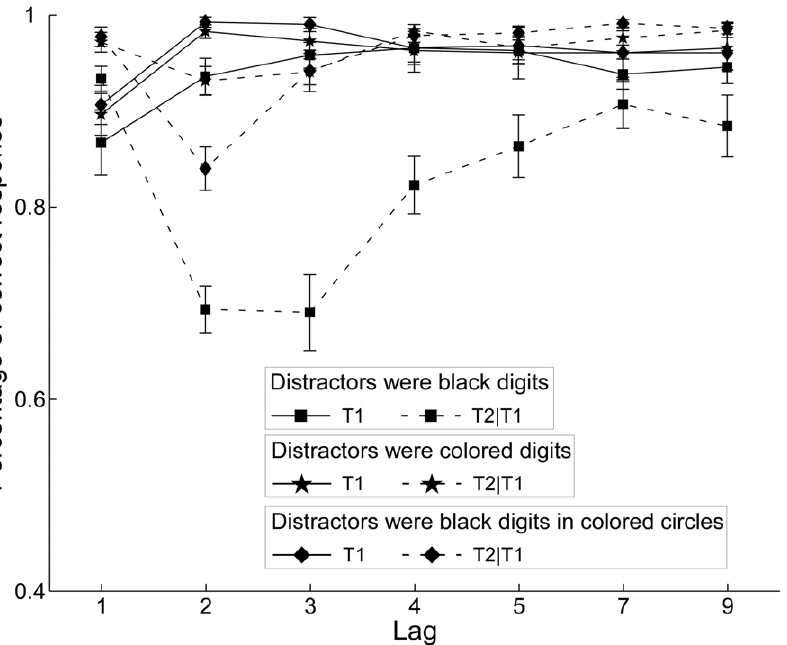
Figure 2. Percentage of correct responses in Experiment 1. Mean percentage correct report of T1 (solid lines) and T2 when T1 was correct (dotted lines) as a function of SOA in the colored digits experimental condition (star symbols), the black digits in colored circles experimental condition (diamond symbols), and the control condition (square symbols) of Experiment 1.